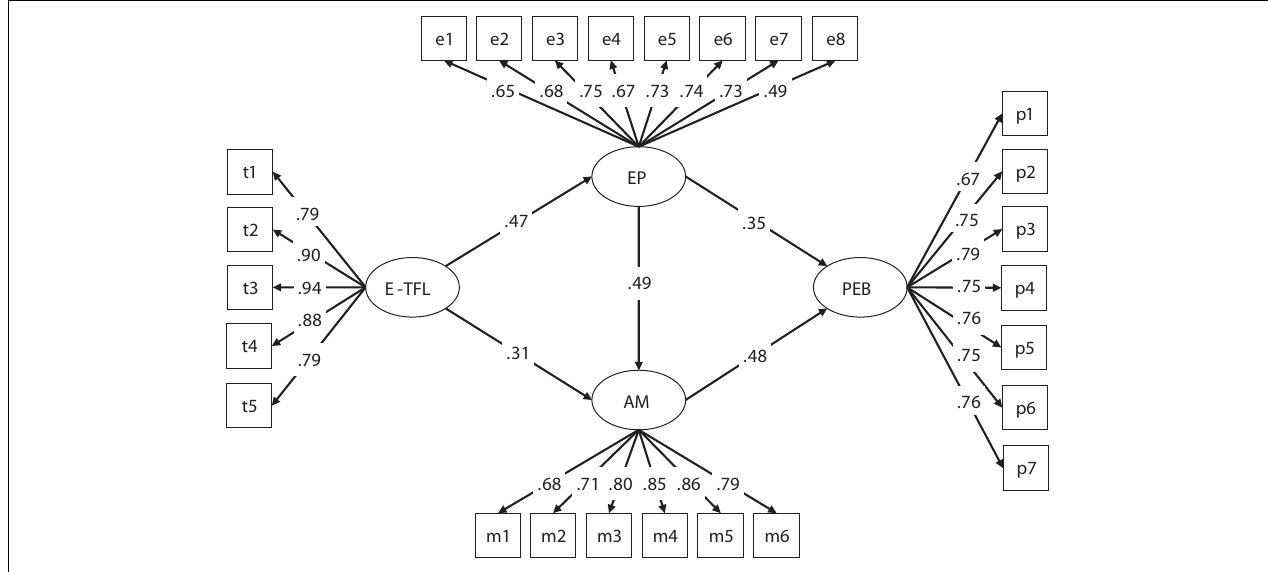
FIGURE 2 | The ultimate mediation model (Model 1). Note: E-TFL, environmentally specific transformational leadership; EP, environmental passion; AM, autonomous motivation. PEB, pro-environmental behavior. All path coefficients and factor loading were significant at p < 0.01.